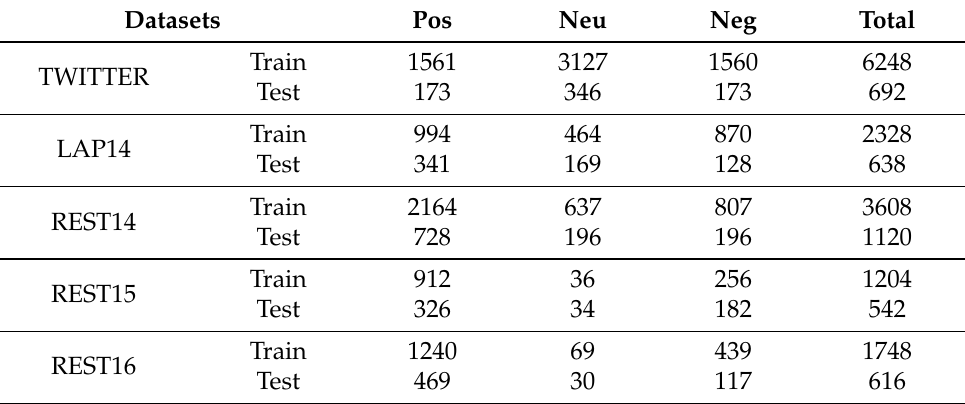
Table 1. Statistics of datasets used in this